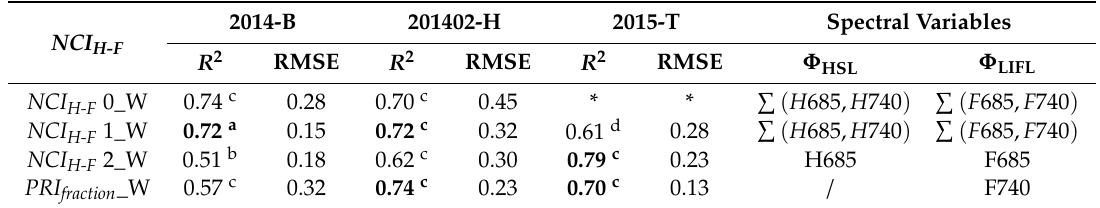
Table 1. FW-based NCI H-F used for LNC estimation and its corresponding R 2 and RMSE for the year of 2014 and 2015 respectively.